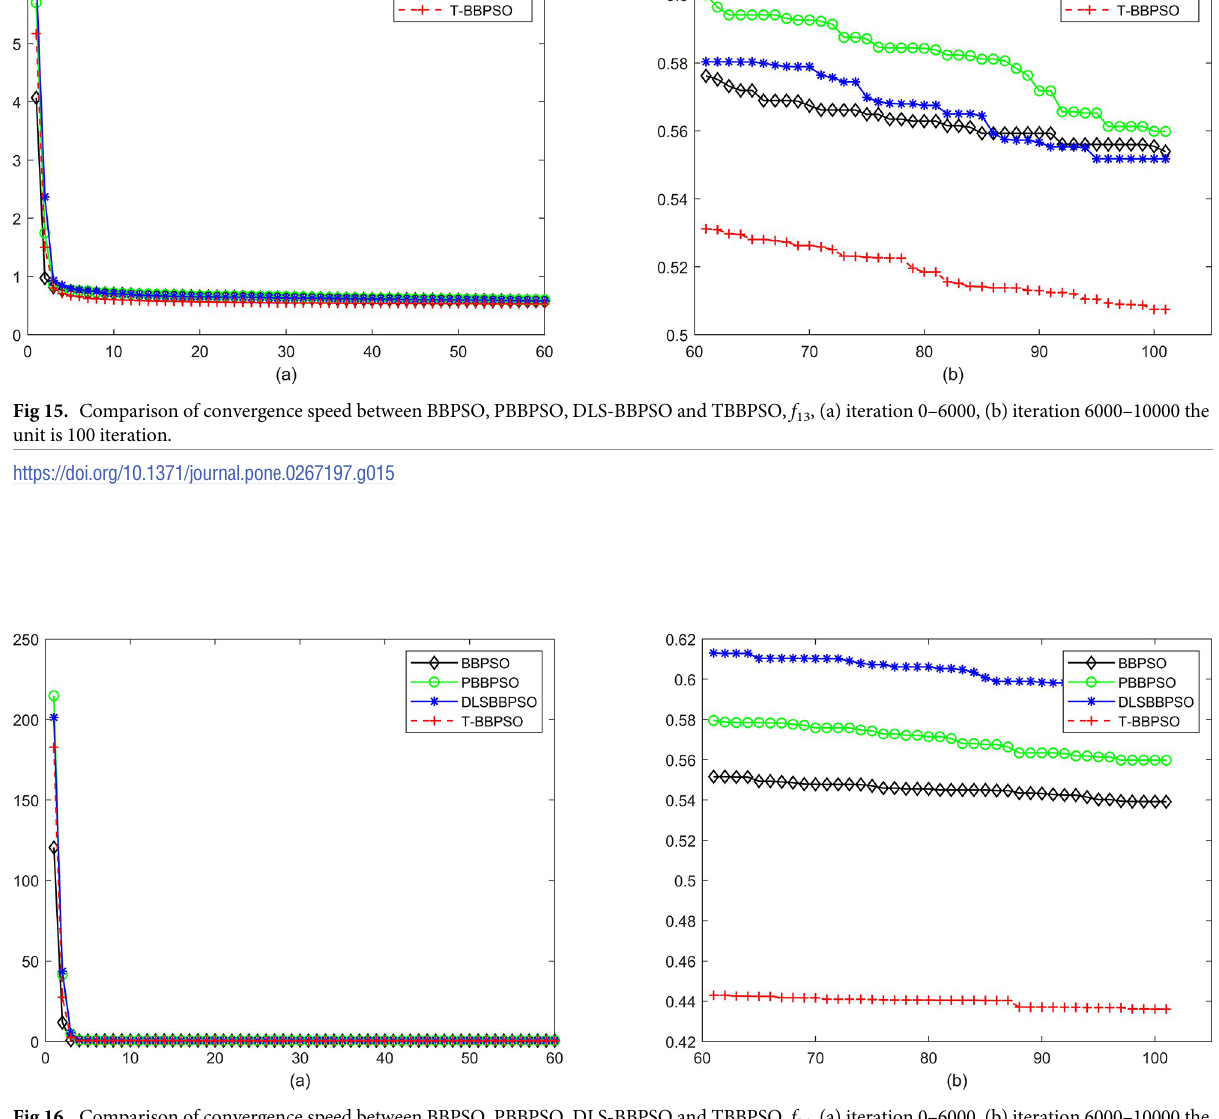
Fig 16. Comparison of convergence speed between BBPSO, PBBPSO, DLS-BBPSO and TBBPSO, f 14 , (a) iteration 0–6000, (b) iteration 6000–10000 the unit is 100 iteration.